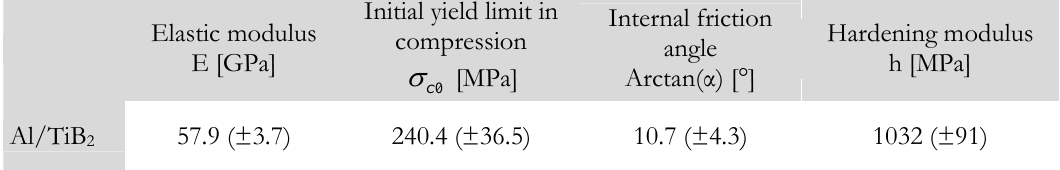
Table 1: Identified material properties after different initializations of the discrepancy minimisation algorithm for an Al/TiB 2 sample with 50% TiB 2 weight